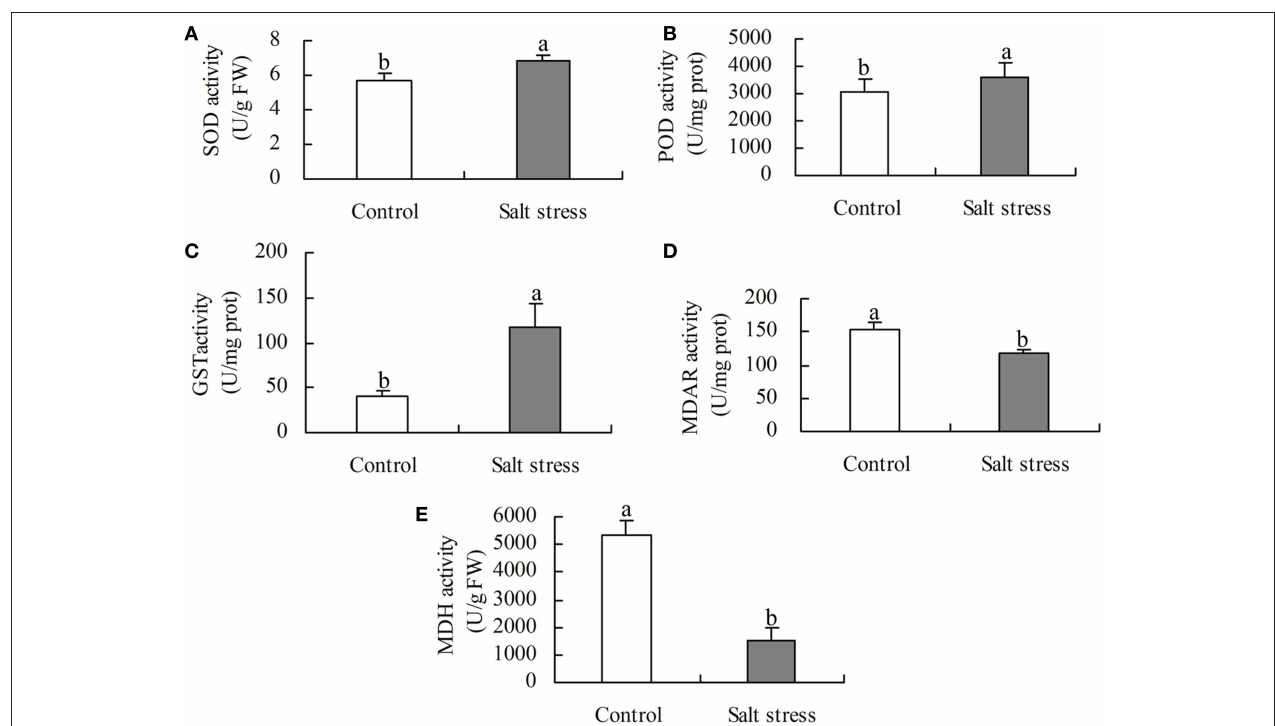
FIGURE 4 | Activity of (A) superoxide dismutase (SOD), (B) peroxides (POD), (C) glutathione S-transferase (GST), (D) monodehydroascorbate reductase (MDAR), and (E) malate dehydrogenate (MDH) in salt stress and control roots. Bars represented means ± SE ( n = 3 ), Different letters above the bar indicate a significant difference at P < 0 . 05